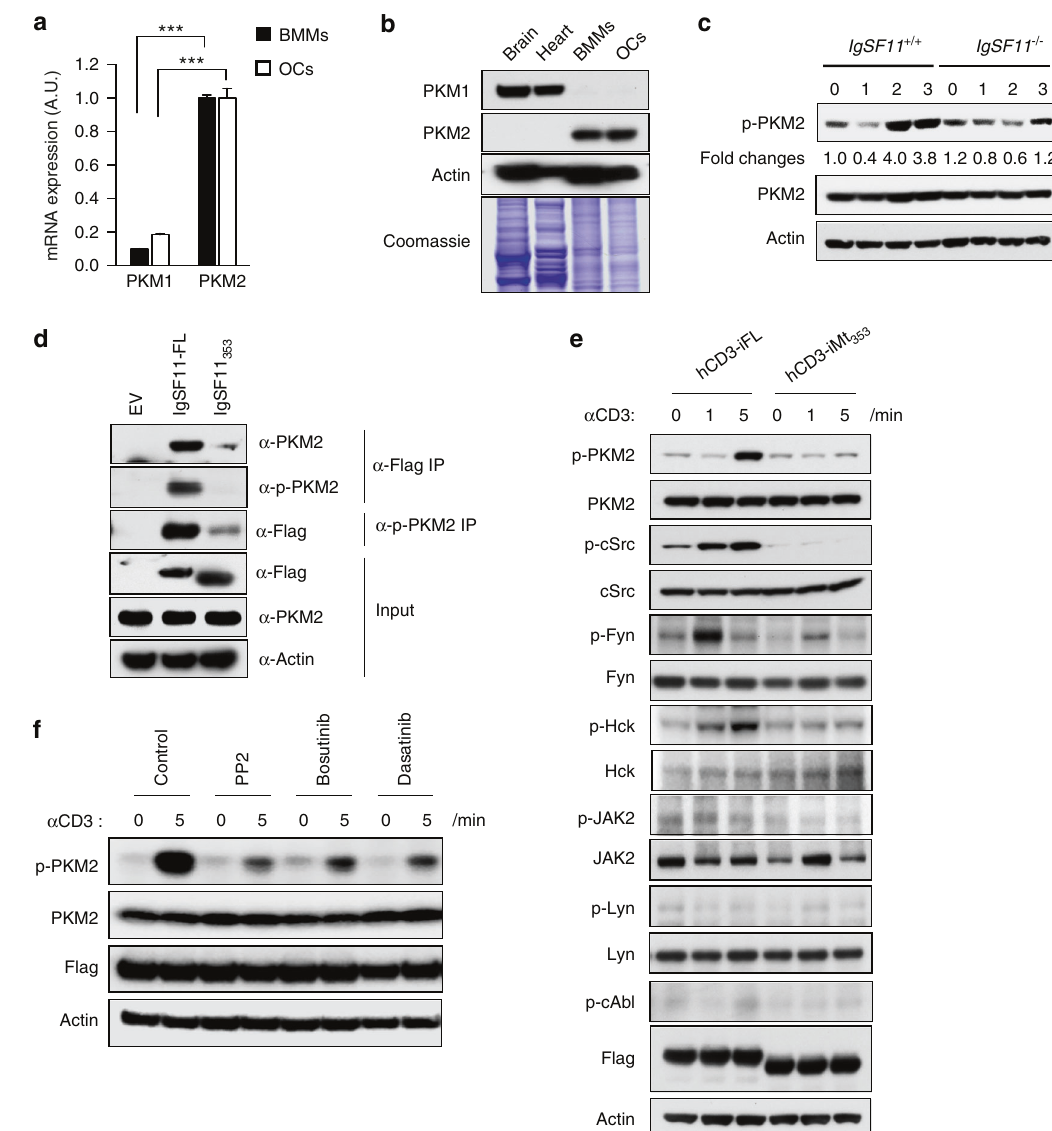
Fig. 2 IgSF11 signaling complexes induce PKM2 phosphorylation. a Comparative expression of PKM isoform 1 and isoform 2 in wild-type cells. Total RNA was isolated from BMMs and osteoclasts and analyzed by Q-PCR. The data are presented as the means ± S.D. b Expression of PKM isoform 1 and isoform 2 in BMMs and osteoclasts. Adult mouse brains and hearts were used as controls. Whole cell/tissue lysates were used for western blotting with the indicated antibodies. Coomassie blue staining is shown as the protein loading control. c Phosphorylation of PKM2 during osteoclast differentiation. BMMs were cultured with M-CSF + RANKL for the indicated days, and whole cell lysates were used for western blotting with the indicated antibodies. d Coimmunoprecipitation of IgSF11 with PKM2. IgSF11 − / − BMMs were retrovirally transduced with the indicated vectors, lysed and immunoprecipitated with anti- Flag antibodies, and western blotting was performed with the indicated antibodies. e IgSF11 induces the phosphorylation of c-Src, Fyn and HcK. IgSF11 − / − BMMs were retrovirally transduced with the indicated vectors, cultured with M-CSF + RANKL for two days and then stimulated with anti-hCD3 antibodies for the indicated times. Western blotting was performed with the indicated antibodies. f Src family kinase inhibitors attenuated PKM2 phosphorylation. IgSF11 − / − BMMs were retrovirally transduced with hCD3-iFL, cultured with M-CSF + RANKL for two days and then stimulated with anti-hCD3 antibodies for the indicated times in the presence or absence of inhibitors (PP2; 4 μ mol·L – 1 , bosutinib; 1 μ mol·L – 1 , dasatinib; 1 μ mol·L – 1 ). Western blotting was performed with the indicated antibodies. The results are representative of at least three independent